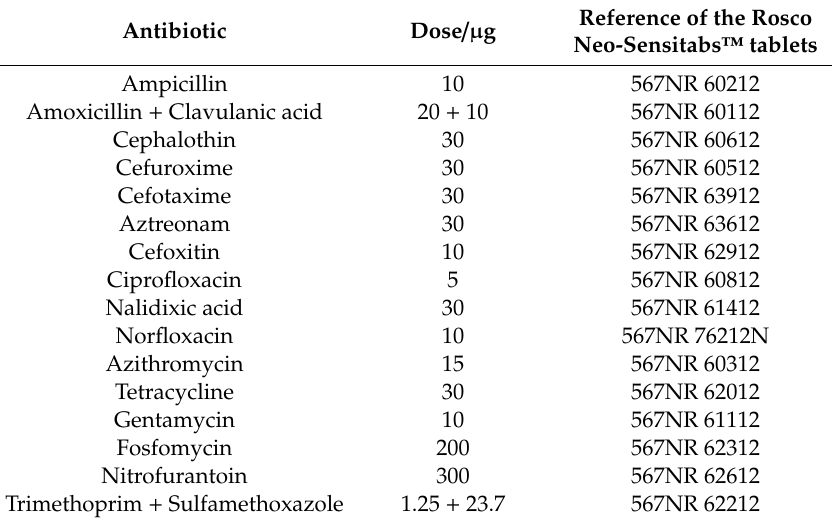
Table 3. Antibiotics tested against the E. coli